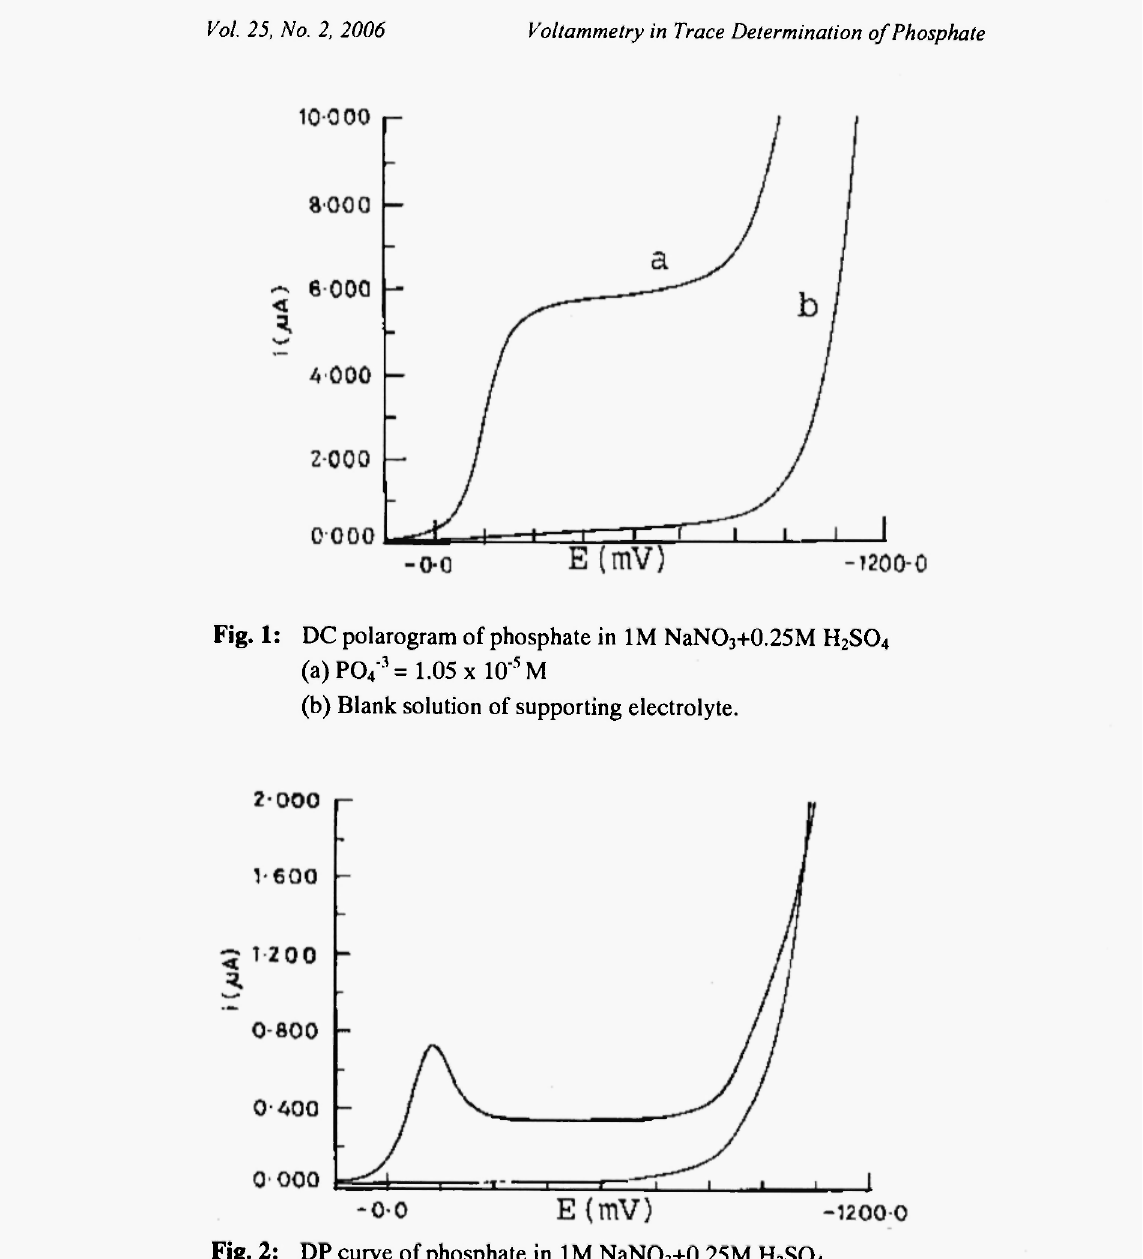
Fig. 2: DP curve of phosphate in 1M NaN0 3 +0.25M H 2 S0 4 P0 4 " 3 = 1.00 ppm Modulation amplitude = 25mV; Drop time = 0.5s and scan rate = 12